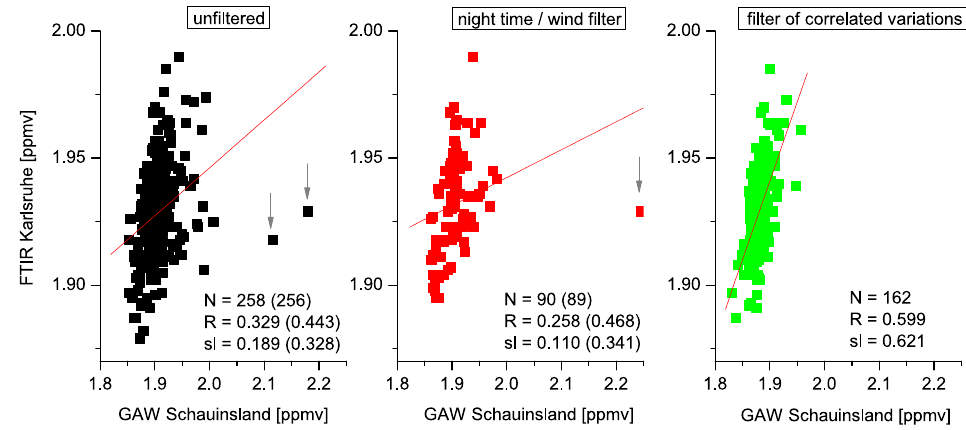
Figure A5. Comparison of coincident Schauinsland in situ and Karlsruhe FTIR CH 4 data for different in situ data filters. Left panel: unfiltered data; central panel: night-time/wind filter; right panel: filter for common signals in the Jungfraujoch and Schauinsland data. The regression lines are shown as red line. The number of achieved daily coincidences ( N ), the correlation coefficient ( R ), and the slope of the regression line (sl) is written in each graph. The N , R , and sl values after removing outliers (which are marked by arrows) are given in parentheses. Note that the plot on the right panel is also shown in Fig. 8 (left panel) but there on an optimised